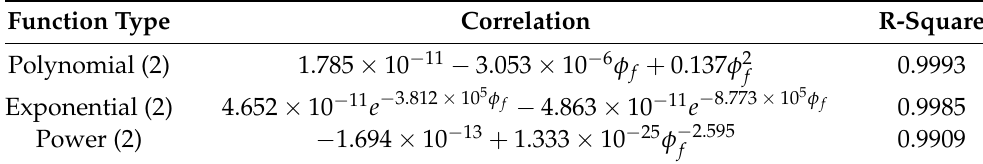
Table 1. Possible correlations to predict the hydraulic permeability of the GDLs as a function of the fiber